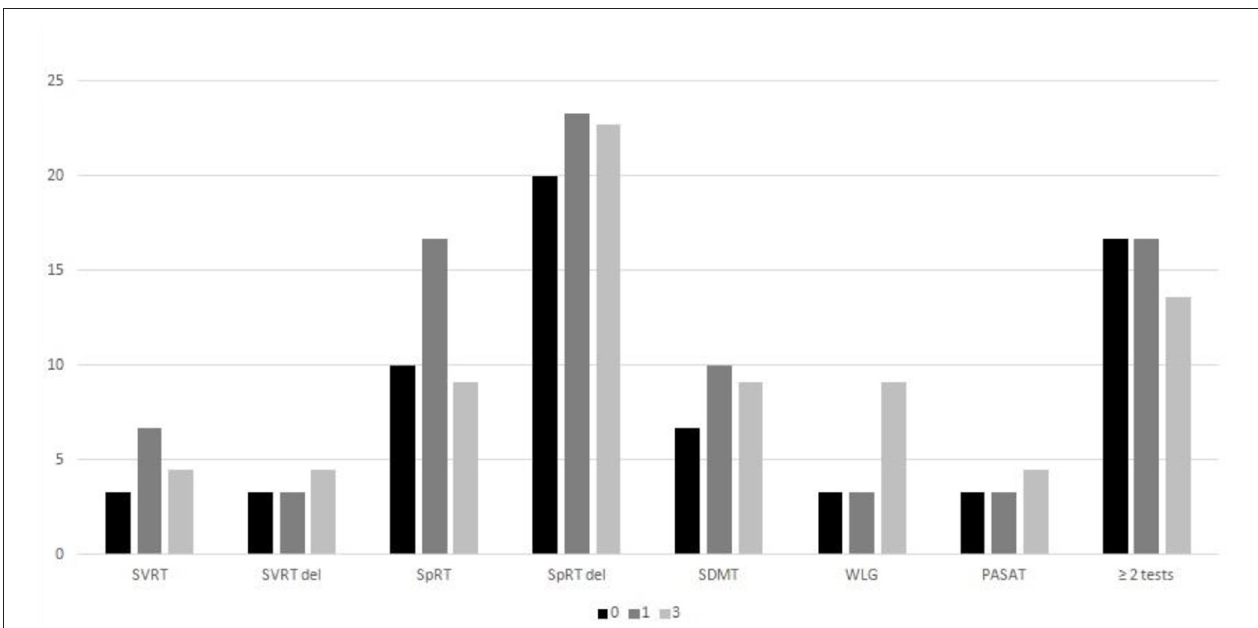
FIGURE 1 | The results of BRBNT during the 3-year follow-up. BRBNT, Brief Repeatable Battery of Neuropsychological Tests.